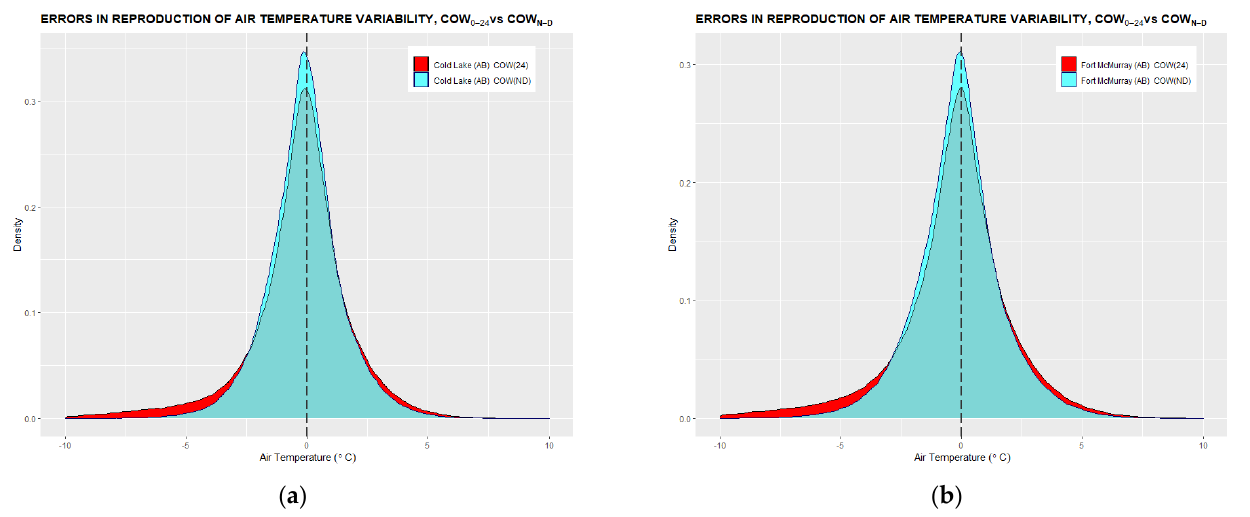
Figure A2. Northwestern Forest climate region. Histograms of conformity of COW 0–24 and COW N–D reproduced temperature with observed hourly temperature data for the 1955–2018 data period at Cold Lake ( a ) and the 1953–2018 data period at Fort McMurry ( b ) stations.